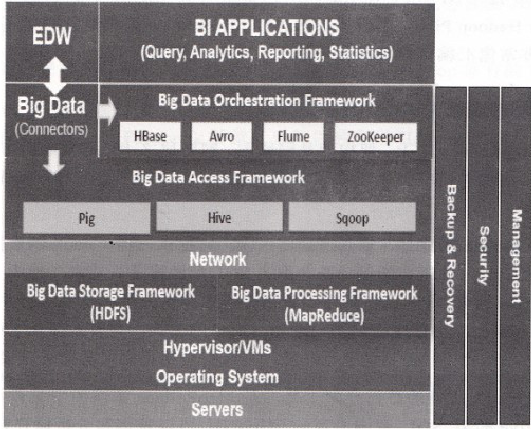
Figure 1. Big data overall architecture reference model